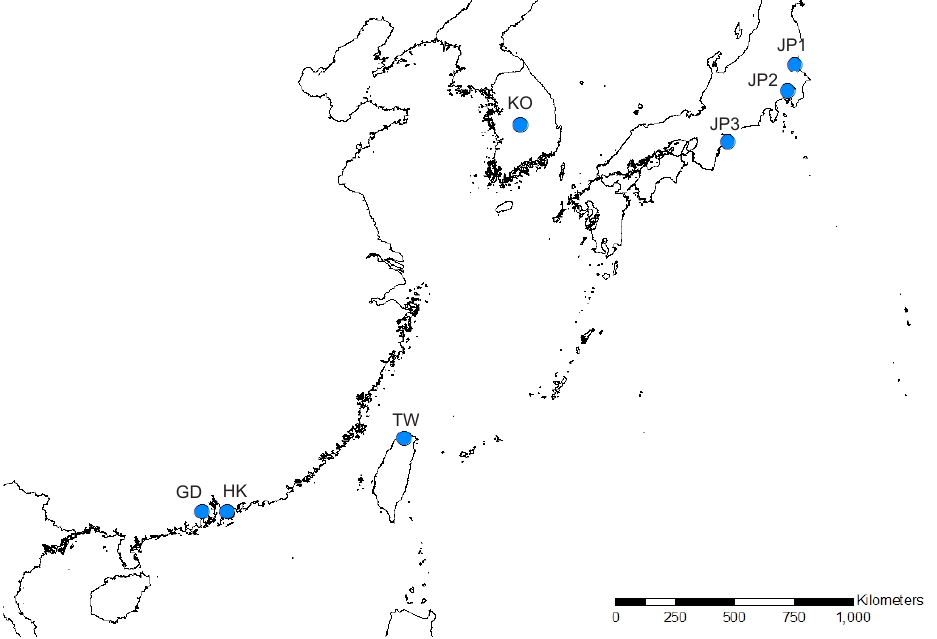
Figure 1. Known global distribution of Mortonagrion hirosei . HK - Hong Kong; GD - Gutoushan, Guangdong, China; JP1 - Ibaraki Prefecture, Japan; JP2 - Sumida Ward, Tokyo, Japan; JP3 - Ise City, Mie Prefecture, Japan; KO - Korea (exact location unknown); TW - Wu Gu wetlands, Taipei,